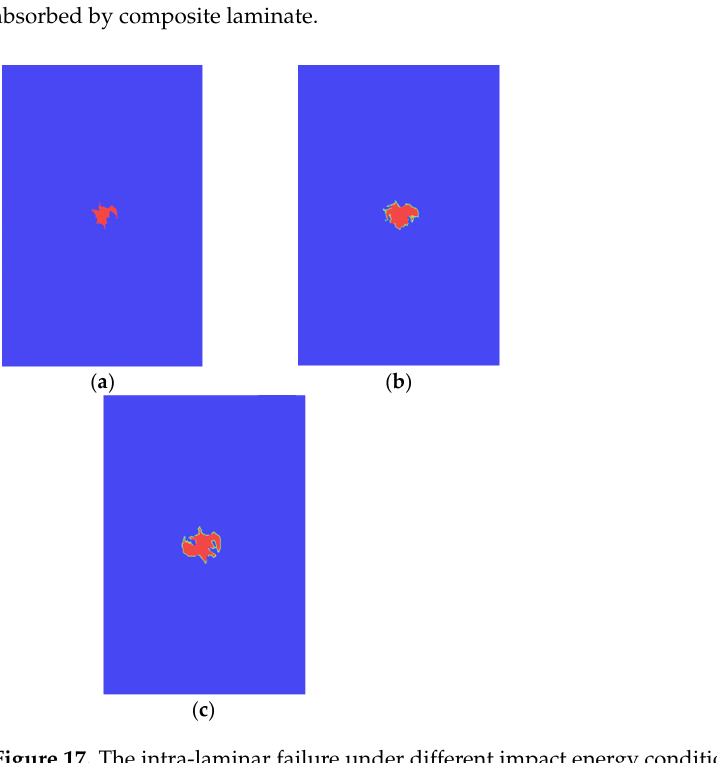
( b ) ( c ) Figure 15. The impact and compression response under different impact energy conditions. ( a ) The contact force curves. ( b ) The compression load versus displacement curves. ( c ) CAI strength with different impact energy. To further explain the above phenomenon, Figure 16 shows the changes to the im ‐ pactor energy and the energy absorption of the composite laminate under different impact energy conditions. It can be seen that the contact time between the impactor and the com ‐ posite laminate becomes longer with the increase in the impact energy, and the energy absorption of the composite laminate also gradually increases. The in ‐ plane damage of the typical laminates under three impact energy conditions, i.e., 30, 40 and 50 J, is shown in Figure 17, and the in ‐ plane damage area gradually increases with the increase in the